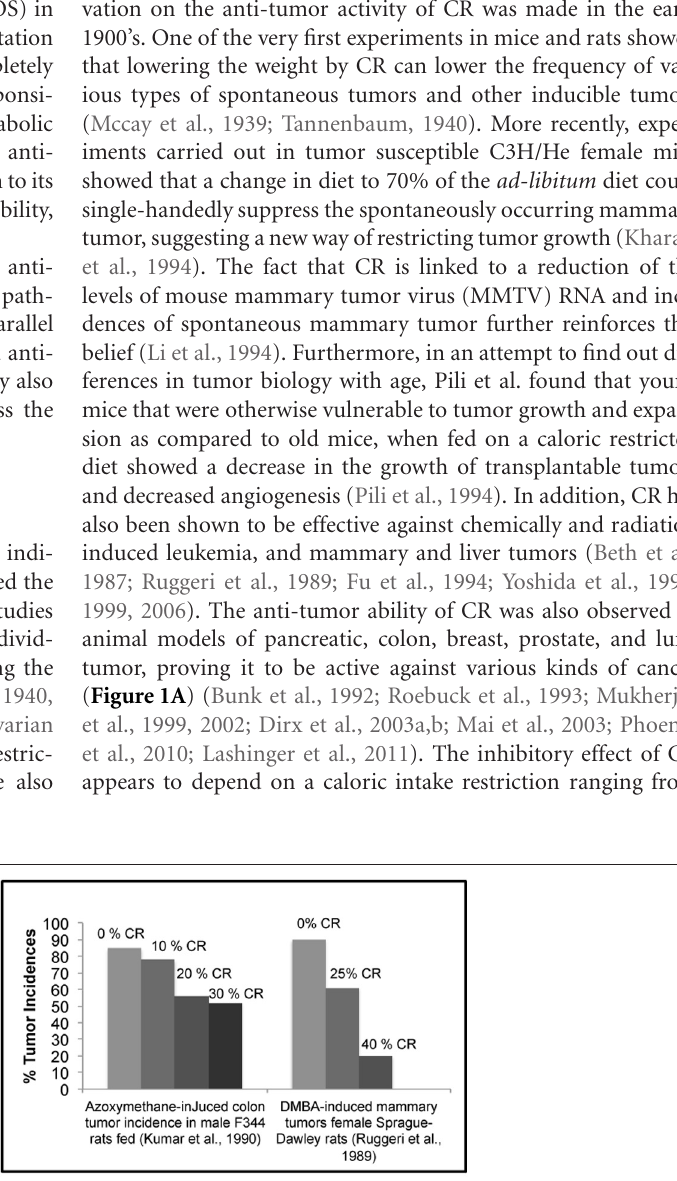
decrease the levels of IGF-1 and ROS and inhibit the PI3K-AKT pathway can simultaneously protect cells from aging and cancer. However, CR ability to maintain telomere length and reduce the frequency of senescence can promote cancer but may be also beneficial in delaying